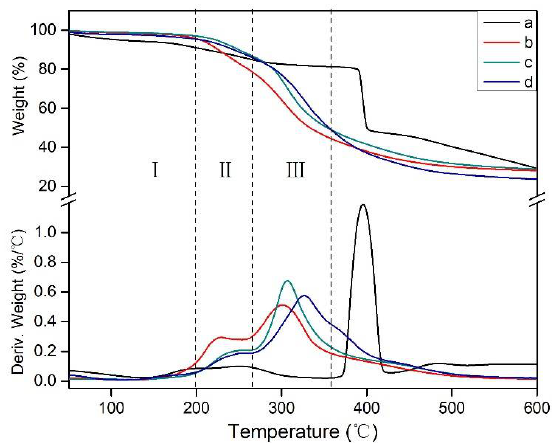
Figure 8. TG and DTG curves of adhesives: a (HMP), b (SF adhesive), c (SF/9% HMP adhesive), and d (SF/18% HMP adhesive). I: First stage, II: Second stage, III: Third stage.